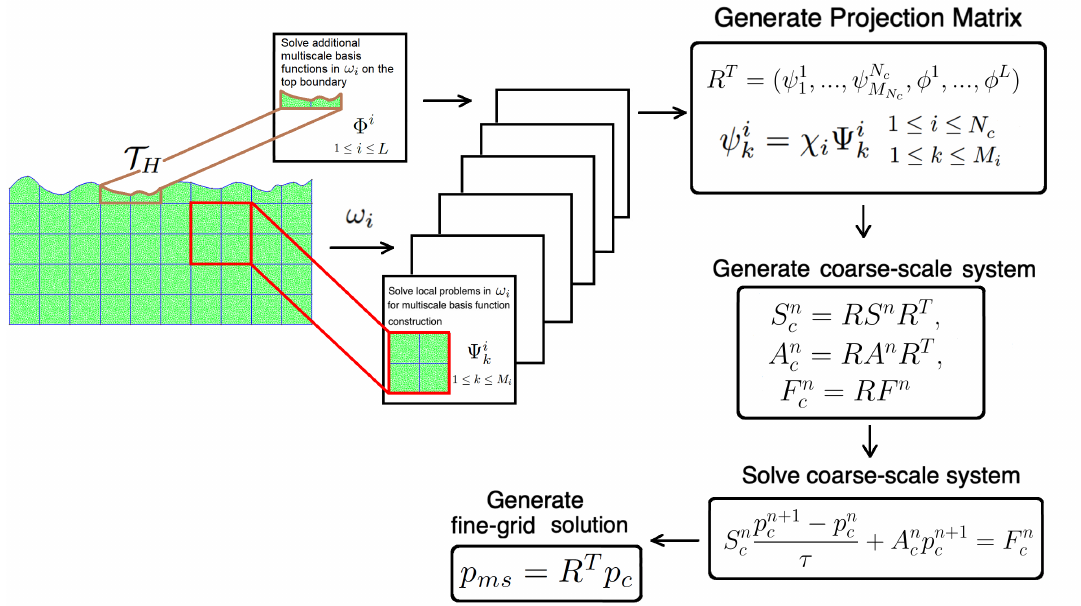
Figure 2. Illustration of the Generalized Multiscale Finite Element Method (GMsFEM)